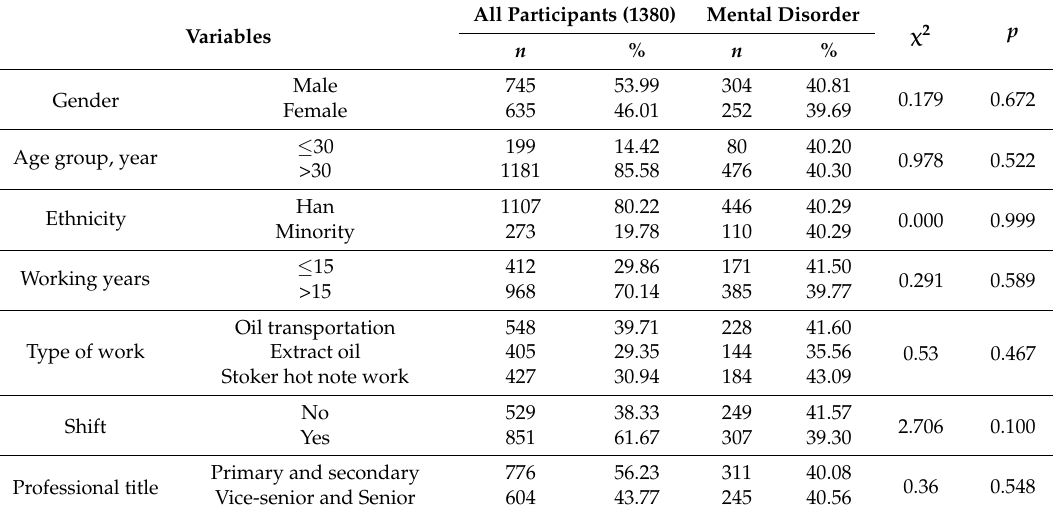
Table 1. Characteristics of the